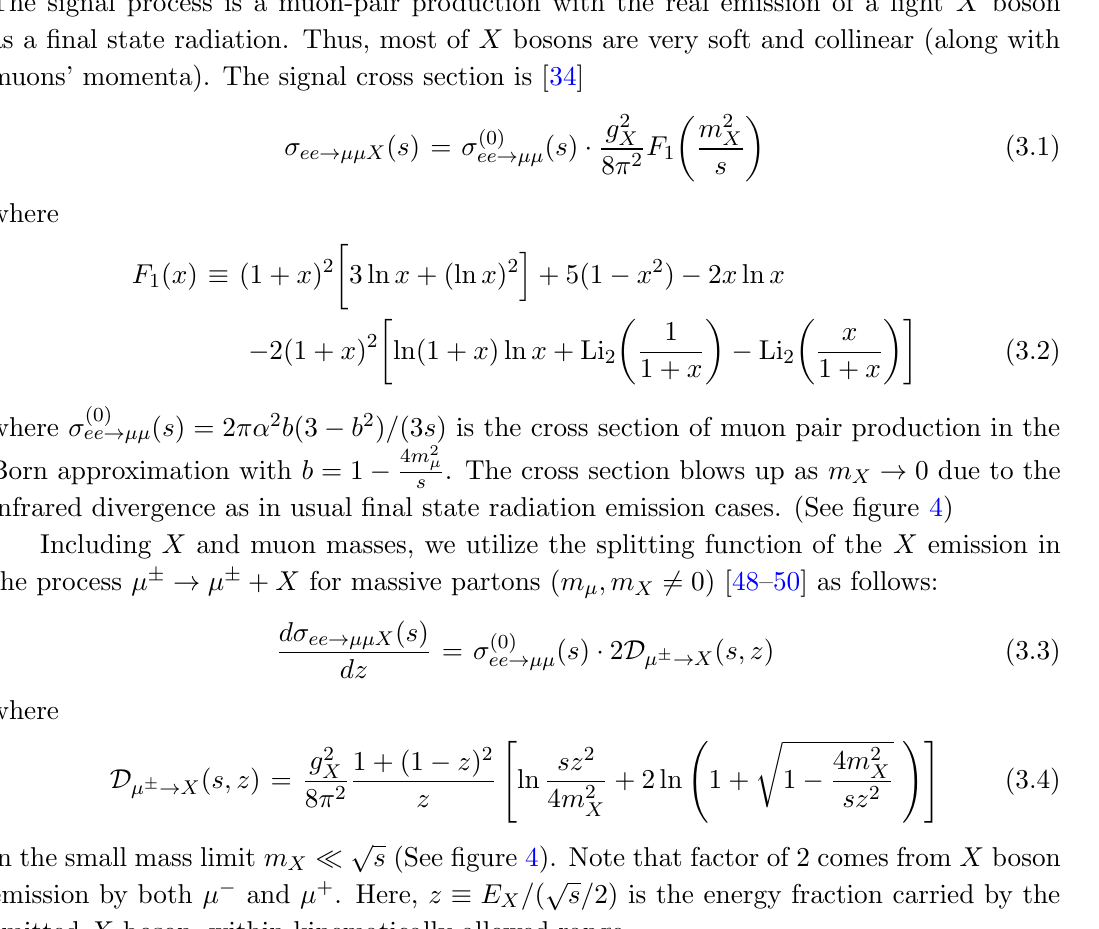
(cid:22) (cid:0) (cid:22) + X ) without any kinematic cut, for ! ( s; z ) with g X = 1 for the X boson emission from D (cid:22) (cid:6) ! X